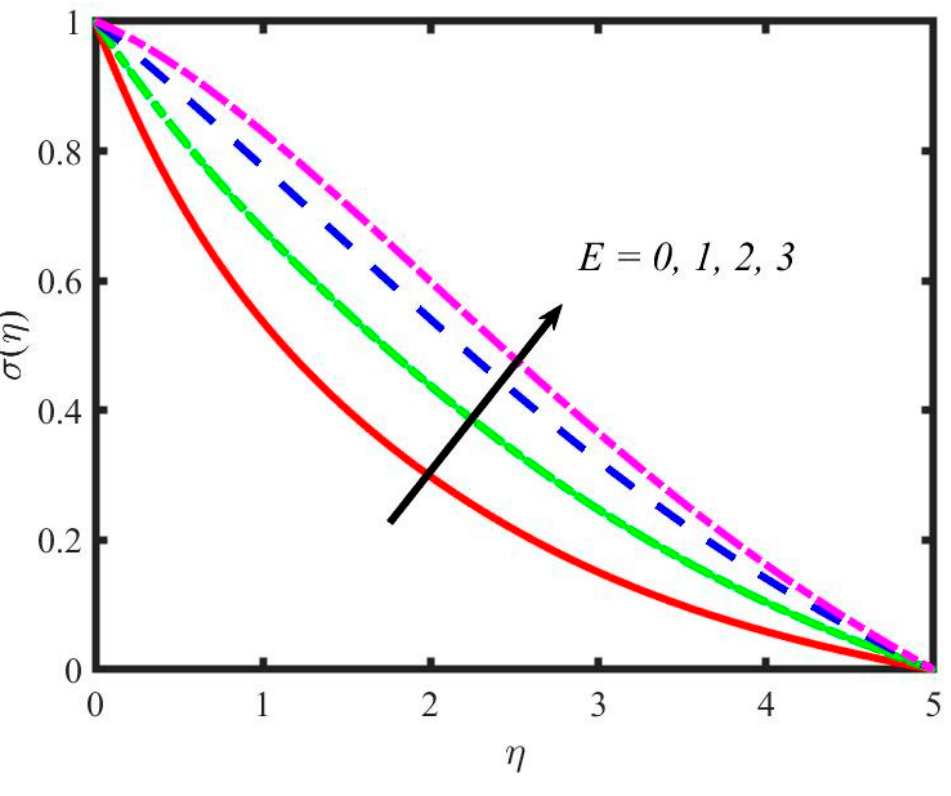
Figure 15. Variations in nanoparticle concentration for activation energy parameter.